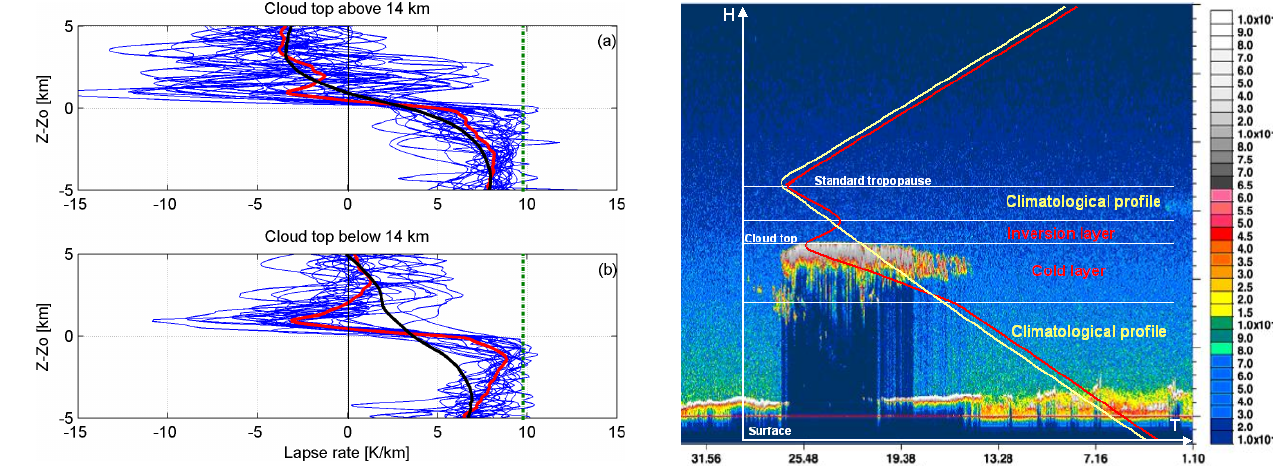
Fig. 10. Atmospheric thermal structure associated with intense con- vective systems, as observed by GPS RO. The yellow line shows a background climatological temperature profile and the red line is the temperature profile when a convective system is present. The background figure is the CALIOP total attenuated backscatter for the case 2 February